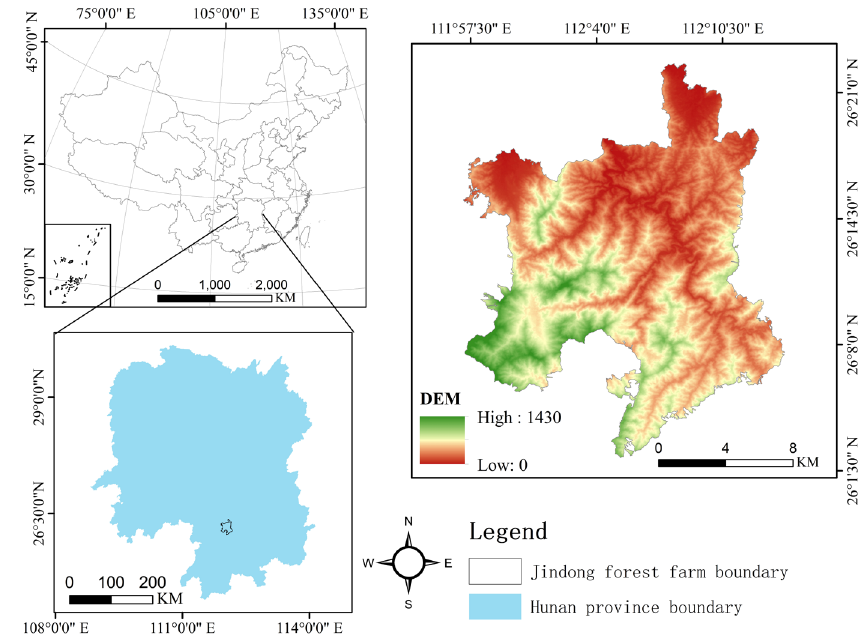
Figure 4. Location of the study